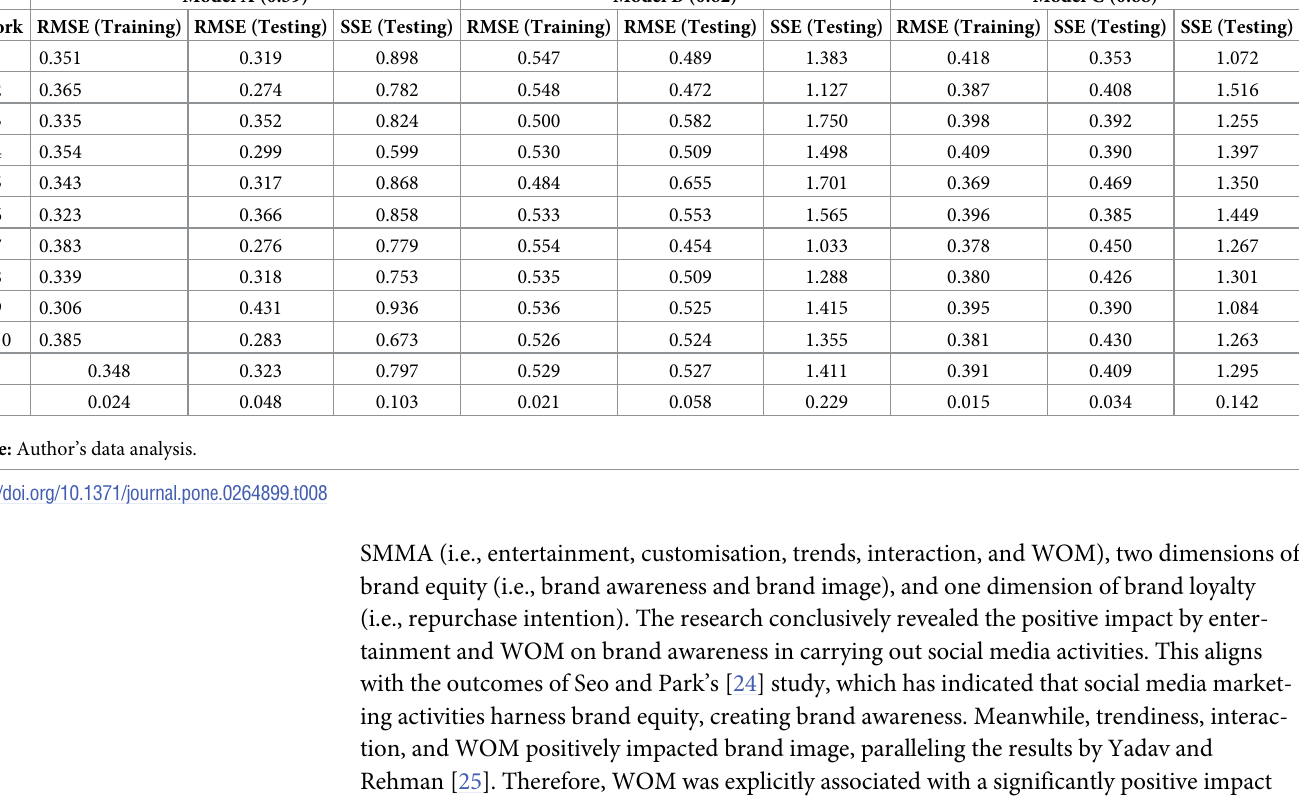
Table 8. RMSE values of Artificial Neural Networks (N = 477). Model A (0.59)